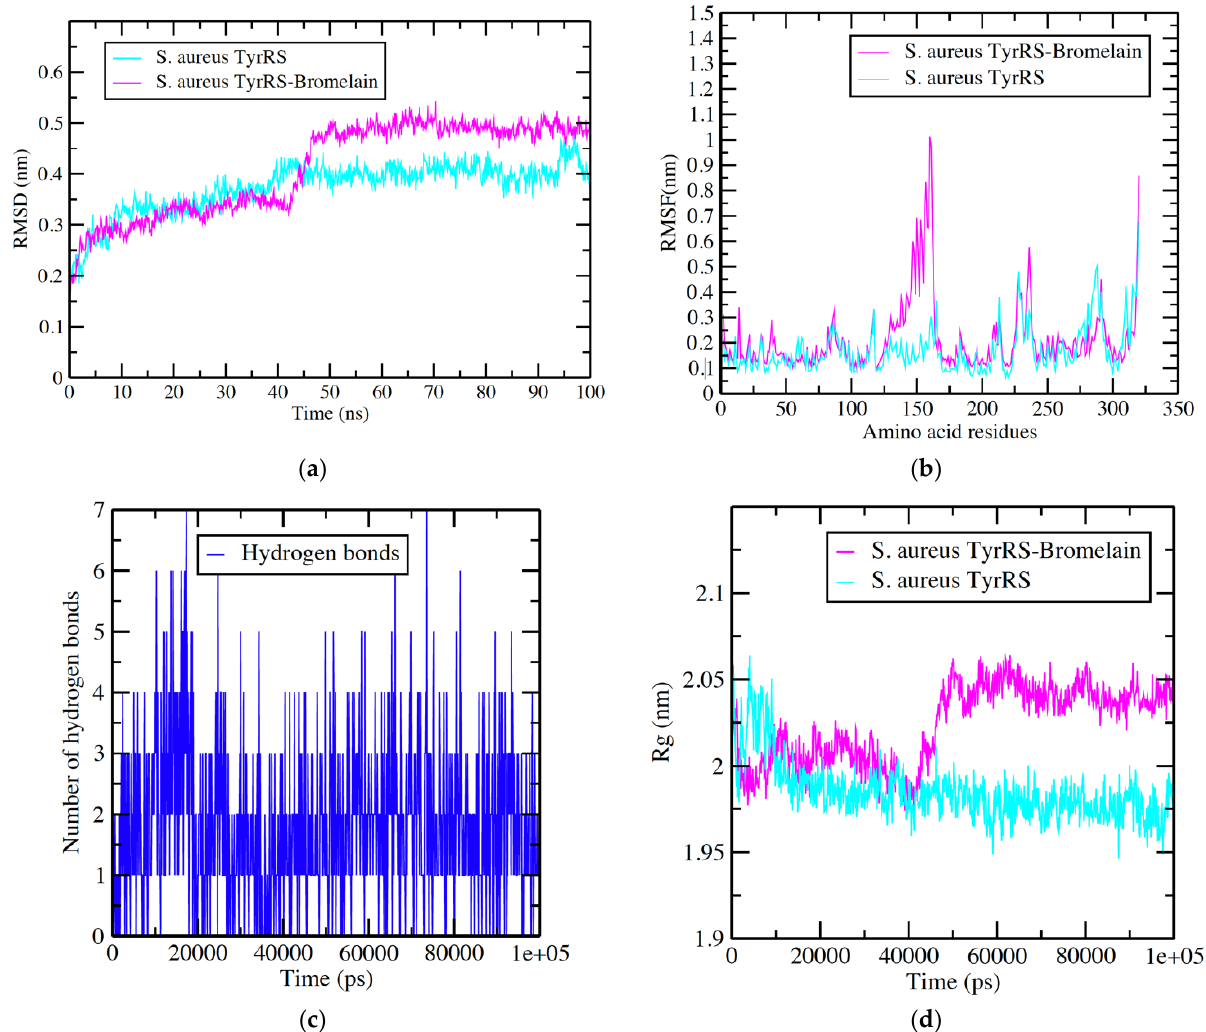
Figure 3. Graphical representation ( a ) RMSD plot of S. aureus TyRS in water (Turquois color) and S. aureus TyrRS–bromelain complex (Pink color) deviation during 100 ns period. ( b ) RMSF plot with fluctuation per residues. ( c ) Hydrogen bond plot showing formation hydrogen bond (Blue color) during 100,000 ps period. ( d ) Radius of gyration (Rg) plot showing compactness of S. aureus TyRS molecule during 100 ns simulation. Where nm = nanometer; ps = picosecond.